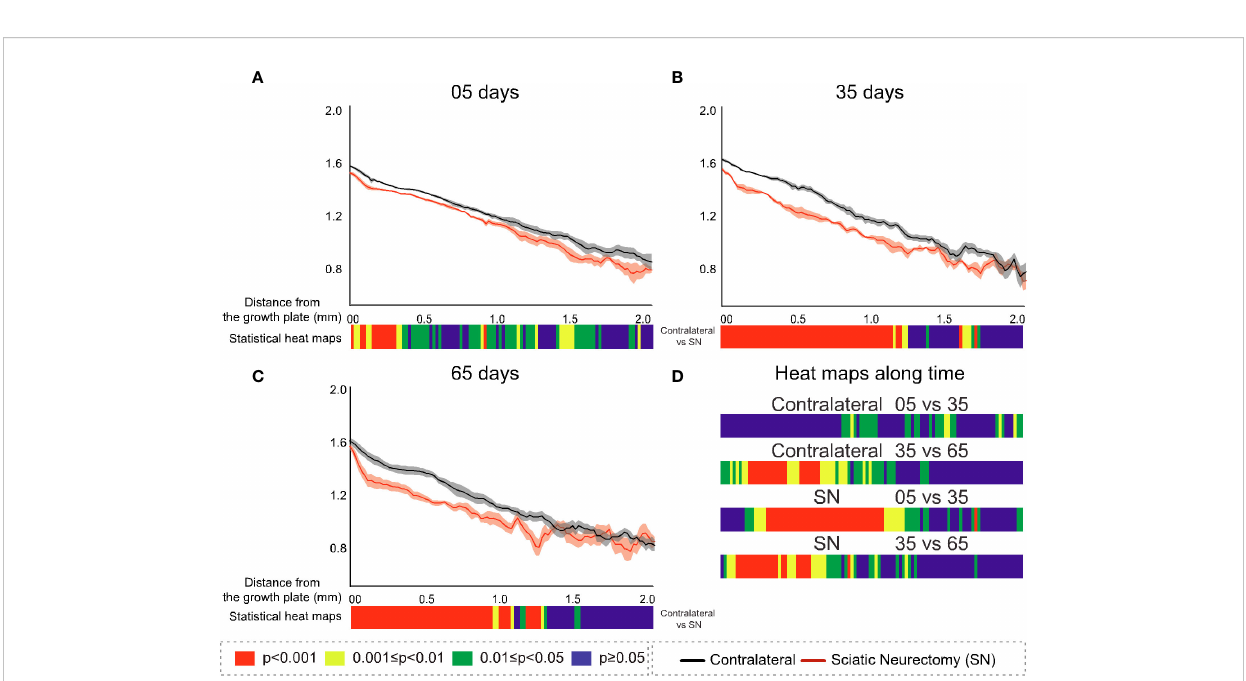
FIGURE 10 Cross-sectional (2D) fractal dimension (FD) with distance from the growth plate in study B in sciatic-neurectomised (SN, red) and contralateral tibias (black) at (A) 5 days, (B) 35 days, and (C) 65 days after surgery. For all pro fi les, the SEM ranges are shown graphically. In each of the three charts, the colour bar below shows the p -value of the signi fi cance of difference (chi-square) by cross-sectional plane (downstream distance) between the left contralateral and right SN tibias. Additional colour bars (D) show if changes occurred earlier or later in the study based on the signi fi cance of difference of the cross-sectional FD with downstream distance in time-based comparisons spanning early and late time intervals for SN and contralateral control